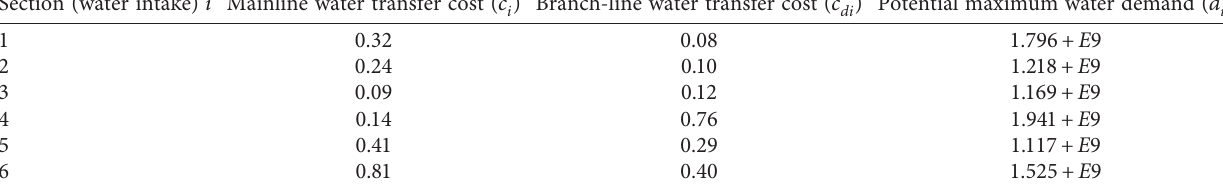
Table 3: Parameter setting.